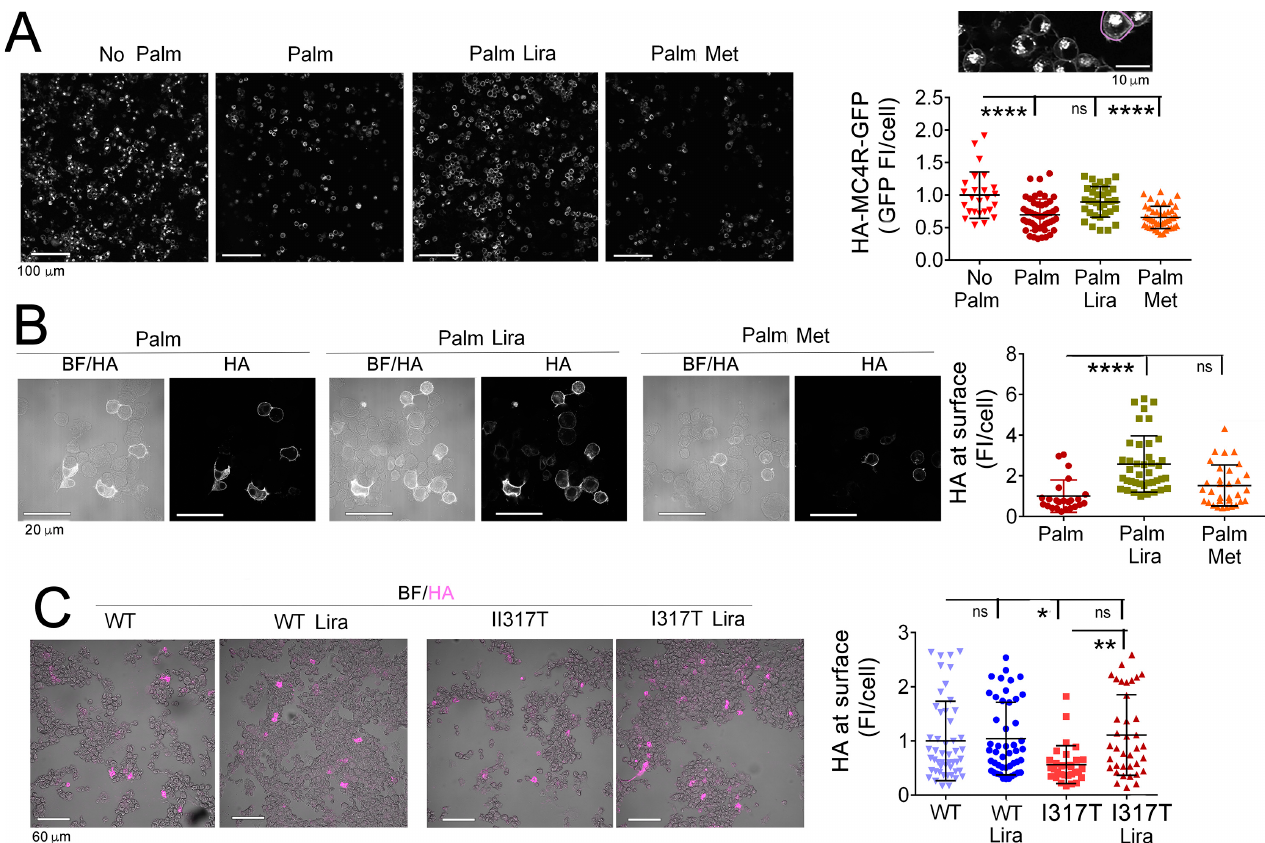
Figure 2. Liraglutide increases MC4R abundance and cell-surface abundance of the receptor in Neuro2A HA-MC4R-GFP cells exposed to elevated palmitate, while metformin is ineffective. ( A ) Live Neuro2A HA-MC4R-GFP cells were incubated for 6 h with 250 µM palmitate (Palm) in the presence and absence of 100 nM liraglutide (Lira) and 2 mM metformin (Met) and imaged by confocal microscopy with the 20× objective. The intrinsic fluorescence intensity (FI) of HA-MC4R-GFP is measured in each cell (encircled by a magenta line in the panel above the graph). ( B ) Neuro2A HA-MC4R-GFP cells were incubated as indicated in ( A ), then fixed as non-permeabilized cells, and immunostained with